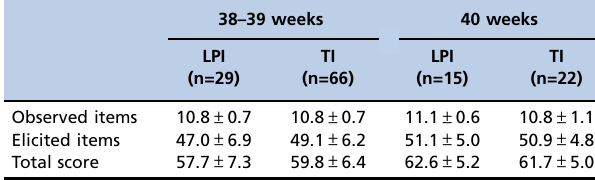
Table 3 - Test of Infant Motor Performance scores of late preterm newborn infants according to corrected age and of term infants at birth